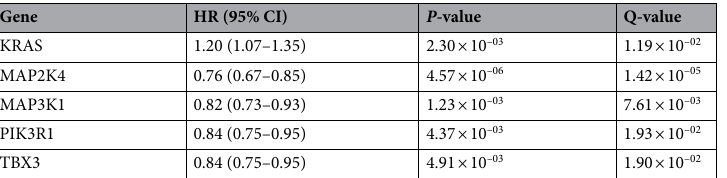
Table 4. Validated association between the expression of driver genes and the overall survival of BRCA patients. One gene, including KRAS with above-median expression levels and four genes, including MAP2K4, MAP3K1, PIK3R1, and TBX3 with below-median expression levels significantly associated with a shortened lifespan. HR is a measure that helps determine whether either of two expression levels of each driver gene will result in an increased (i.e., HR > 1) or decreased (i.e., HR < 1) probability of experiencing the defined event (i.e., death), at any time (below-median expression level is the reference). P -value is computed by the